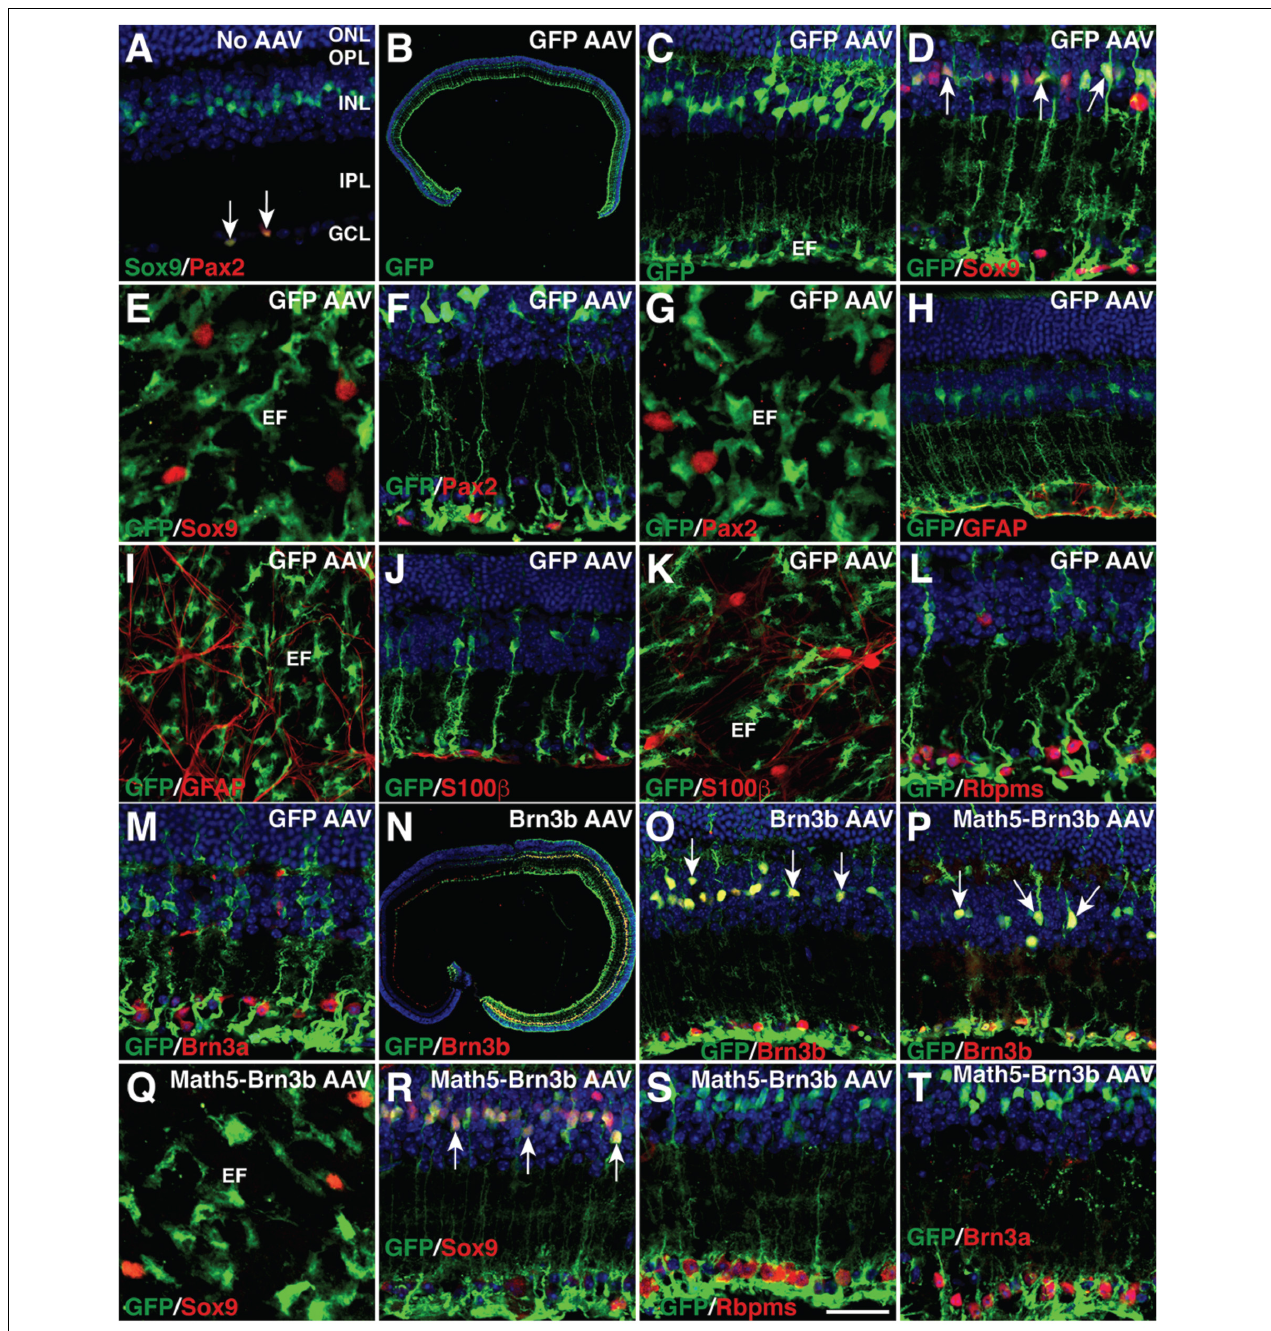
FIGURE 2 | MG-specificity of the GFAP promoter in adult mouse retinas. (A) Sections from retinas without AAV infection were double-immunolabeled with antibodies against Sox9 and Pax2 and counterstained with nuclear DAPI. Arrows point to co-labeled cells. Sox9 and Pax2 are completely co-localized in astrocytes within the GCL. (B–M) Two weeks after infection with GFAP-GFP AAVs, sections (B–D,F,H,J,L,M) or flat-mounts (E,G,I,K) from infected retinas were immunolabeled with the indicated antibodies. Sections were also counterstained with nuclear DAPI. Arrows point to representative co-labeled cells. The GFP+ cells are not immunoreactive for Sox9, Pax2, GFAP, or S100 β in the GCL (D–K) , nor are they immunoreactive for Rbpms or Brn3a (L,M) . (N,O) Two weeks after infection with GFAP-Brn3b-GFP AAVs, sections from infected retinas were immunolabeled with antibodies against GFP and Brn3b and counterstained with nuclear DAPI. Arrows point to representative co-labeled cells. (P–T) At 3.5 (Q–T) and 5.5 (P) days after infection with GFAP-Math5-Brn3b-GFP AAVs, sections (P,R–T) or flat-mount (Q) from infected retinas were immunolabeled with the indicated antibodies. Sections were also counterstained with nuclear DAPI. Arrows point to representative co-labeled cells. At day 3.5, the GFP+ cells are not immunoreactive for Sox9 in the GCL (Q,R) , nor are they immunoreactive for Rbpms or Brn3a (S,T) . EF, MG endfoot; GCL, ganglion cell layer; INL, inner nuclear layer; IPL, inner plexiform layer; ONL, outer nuclear layer; OPL, outer plexiform layer. Scale bar: 640 µ m (B) , 457 µ m (N) , 40 µ m (C,H–K,O,P) , 30 µ m (A,D,F,L,M,R–T) , 20 µ m (E,G,Q) .